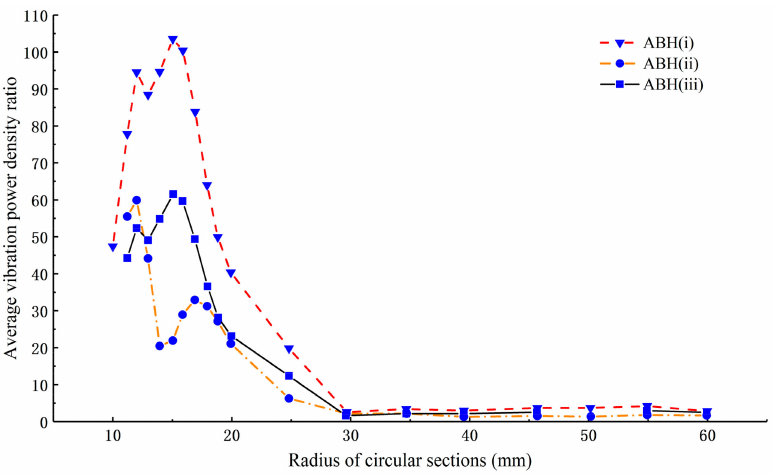
Figure 12. Average vibration power density ratios at excitation frequencies of 1100